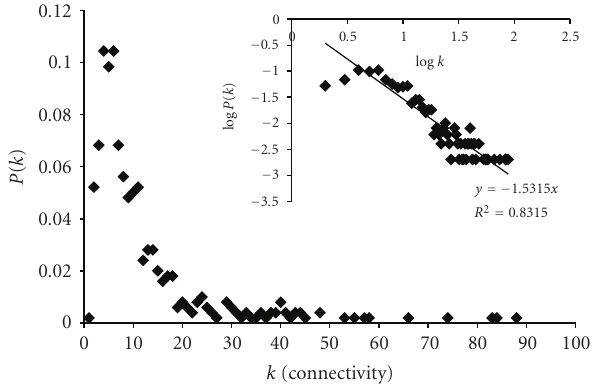
Figure 2: Degree (connectivity) distribution of the nodes in the reconstructed insulin signaling protein interaction network.